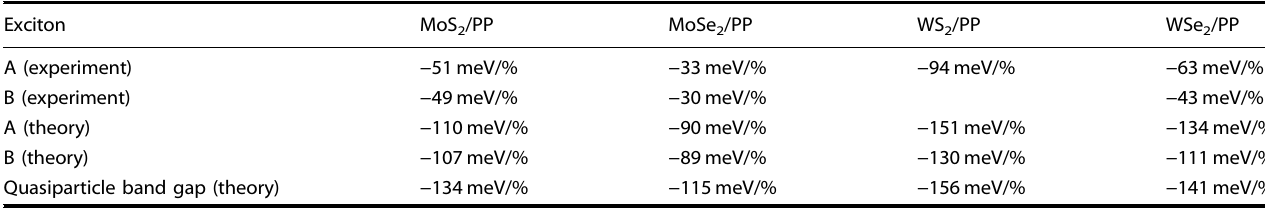
Quasiparticle band gap (theory) Gauge factor for excitons A and B; the experimental values are extracted from applying biaxial strain on the different 2D fl akes. The theoretical values stem from the calculated absorption spectra (BSE). Also included are the gauge factors of the quasiparticle gap, i.e. the VBM to CBM direct band gap at the K